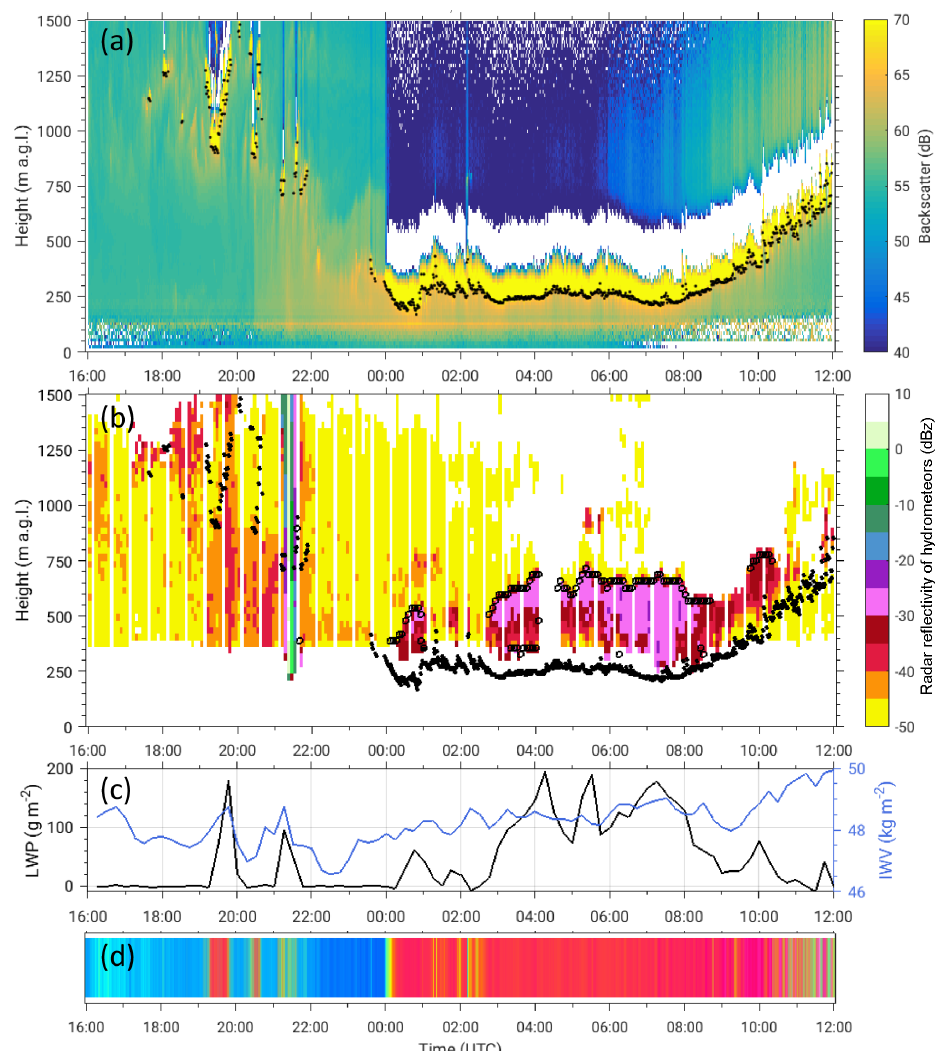
Figure 3. (a) Time series of ceilometer backscatter (color) and CBH (black dots) derived from the backscatter profiles. (b) The reflectivity of hydrometeors obtained by cloud radar (color), the CBH (black dots), and CTH (open circles) derived from the cloud radar using a threshold of − 35dBz. (c) Time series of 30min averaged LWP and IWV from microwave radiometer. (d) The RGB coded image of sky conditions obtained by IR cloud camera. The image shows relative contributions of red, green, and blue in a given pixel, where the color of the pixel depends on the emissivity of the sky area and its brightness temperature. The blue colors correspond to clear sky and the red color indicates